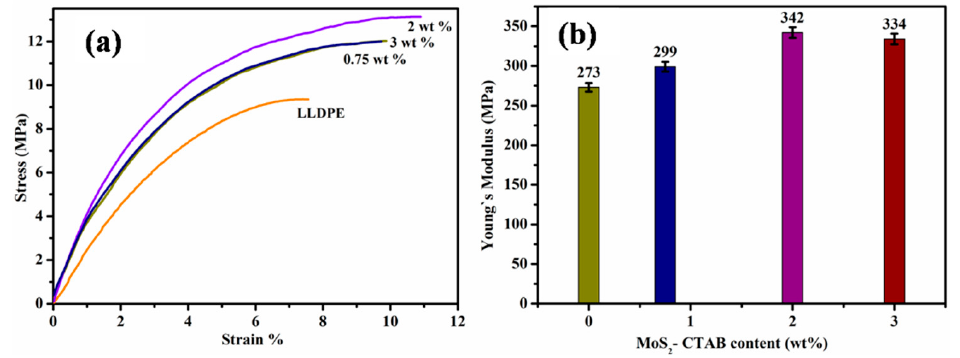
Figure 4. Stress–strain curve of neat LLDPE and its composites with CTAB–MoS 2 at various loadings ( a ) and variation of Young’s modulus with weight percentage of CTAB–MoS 2 ( b ).